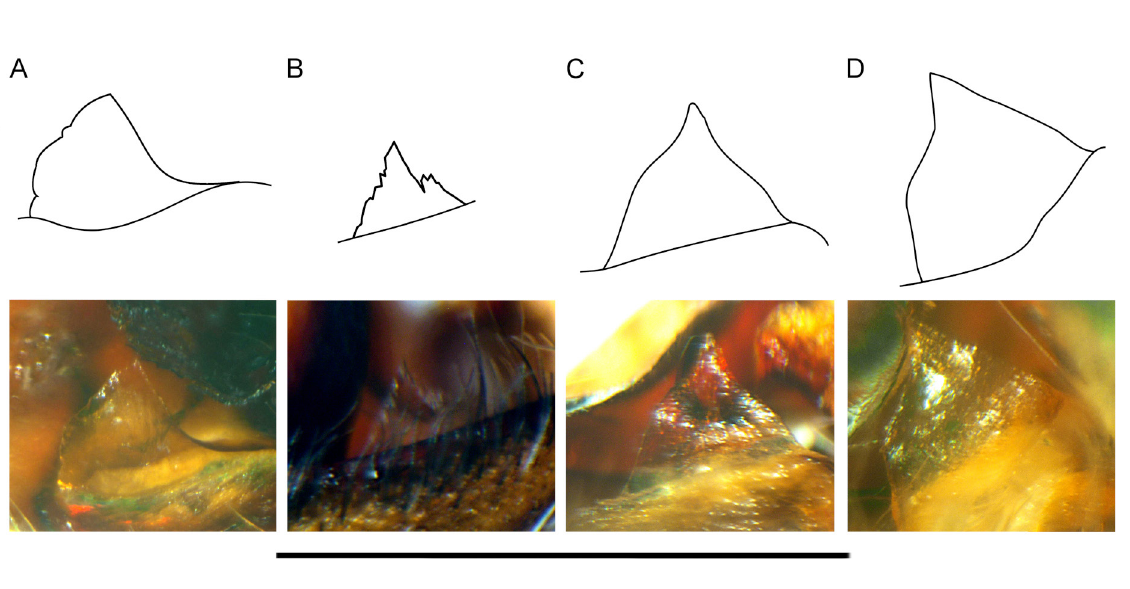
Fig. 12. Lycosa ♂♂, conductor tip, photograph and outline. A . Lycosa praegrandis C.L. Koch, 1836. B . Lycosa gesserit sp. nov., holotype (HUJ INV-AR20631). C . Lycosa hyraculus sp. nov., holotype (HUJ INV-AR20818). D . Lycosa piochardi Simon, 1876 (HUJ INV-AR20855). Scale bar = 0.5 mm. Photos and drawings by I. Armiach